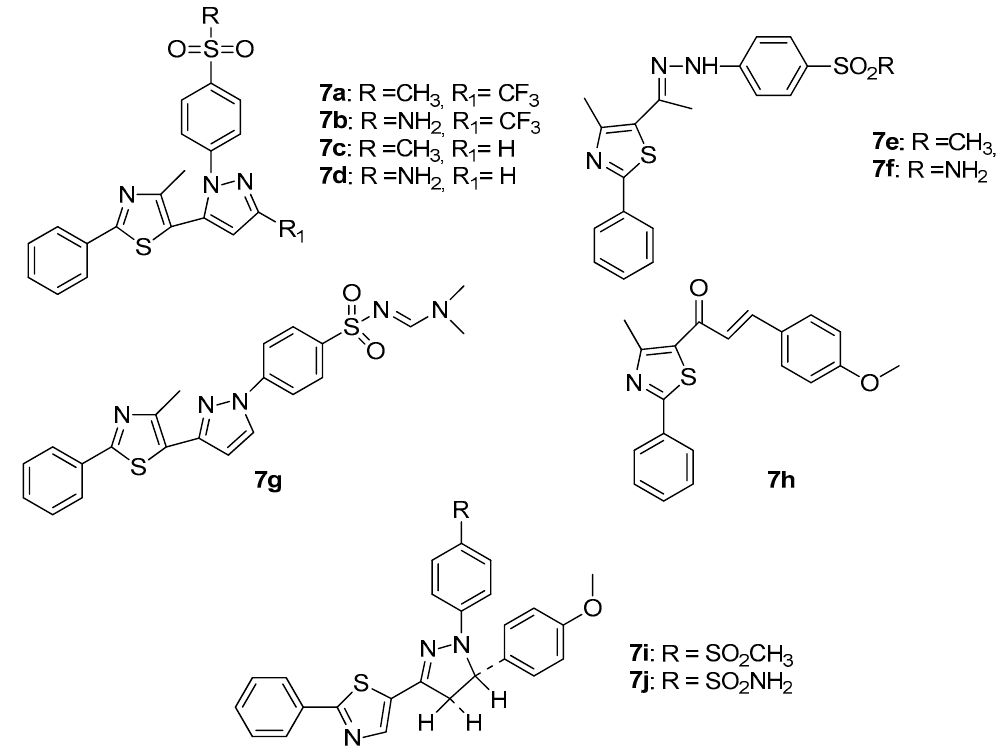
Figure 8. Structures of thiazolo-celecoxib analogues.